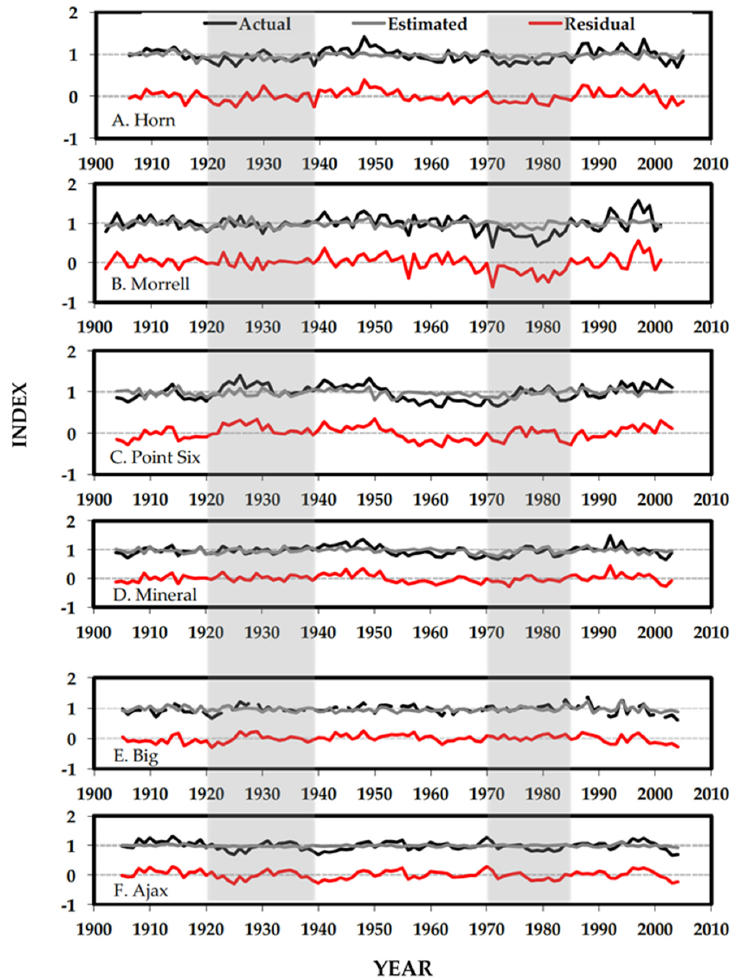
Figure 4. PRECON results for most significant monthly climate variables and actual, estimated, and residual indices of whitebark pine chronologies at six sites ( A – F ). “Actual” (black) indicates the whitebark pine radial growth, “estimated” (gray) indicates the predicted annual whitebark pine growth based on the significant monthly climate variables, and “residual” (red) is the difference between the actual and estimated chronologies from 1905 to 2005. The gray bars highlight mountain pine beetle outbreak periods.